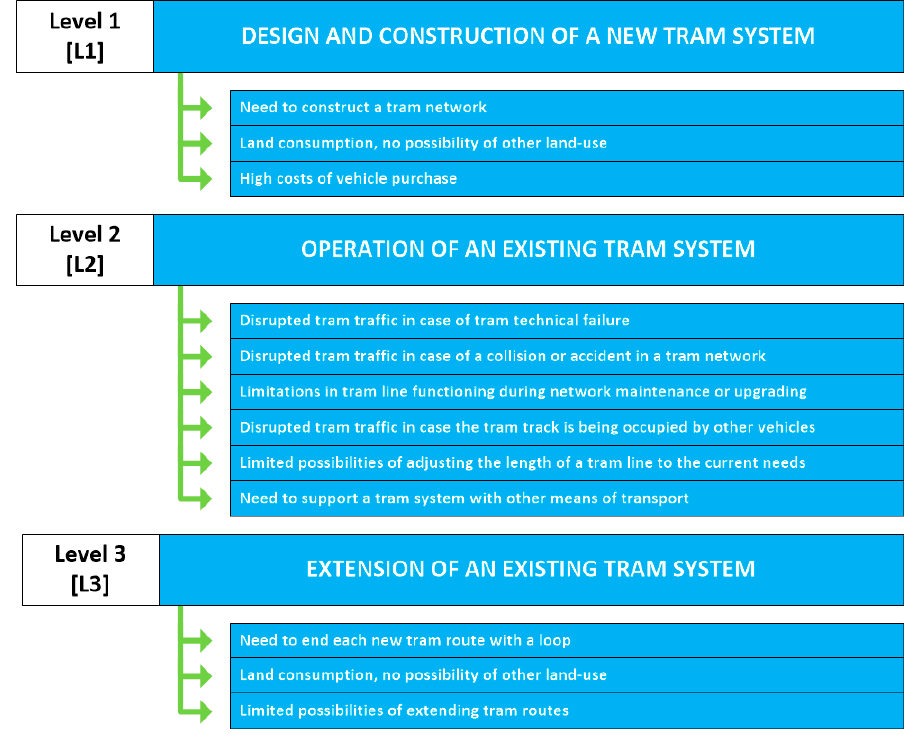
Figure 2. Uni-directional tram system limitations—results of the expert analyses.